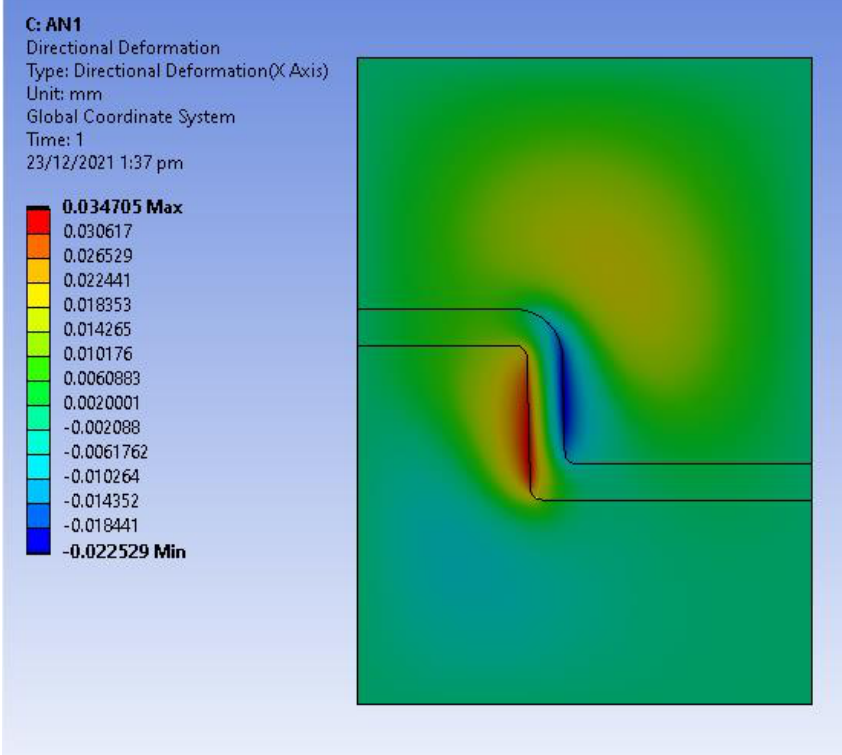
Figure 11. Directional deformation in X -axis at 45 s (expansion of tool and shrinkage of part during cooling stage).